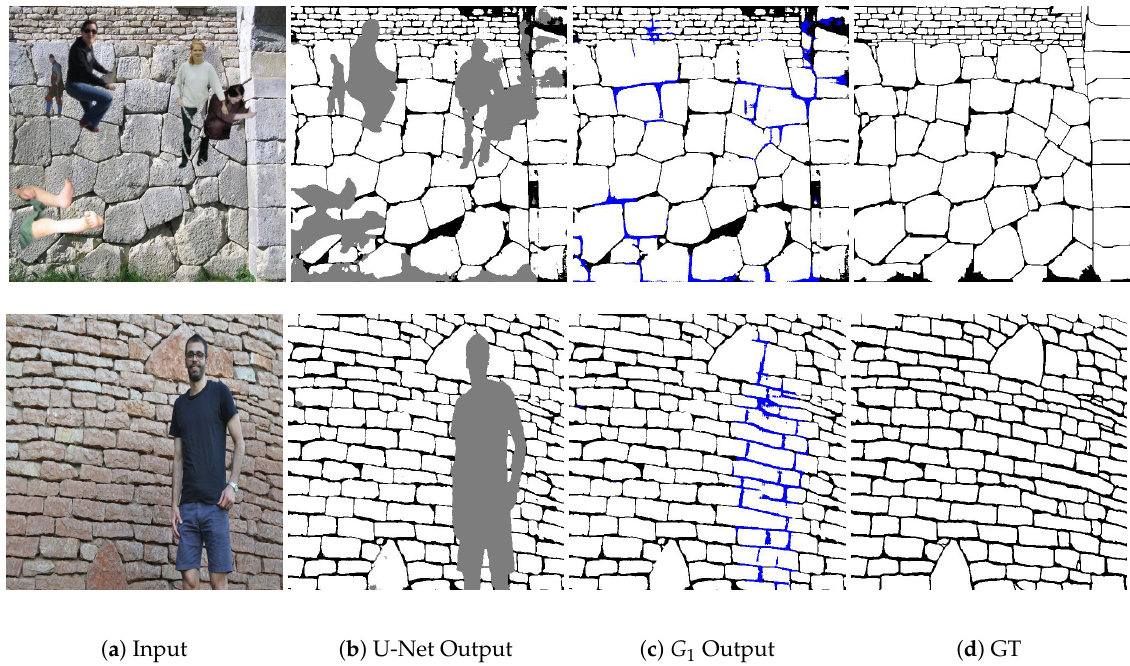
Figure 8. Structure inpainting results (first GAN ): ( a ) Input: wall image occluded by irregular objects (first row: synthetic occluding objects, second row: real occluding objects), ( b ) U-Net output, ( c ) G 1 output: inpainted mortar-brick map (predicted mortar pixels in blue), ( d ) Ground Truth